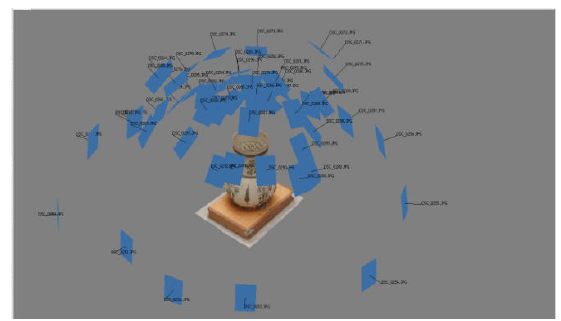
Figure 6. Dataset pose reconstruction of Samovar for infusion